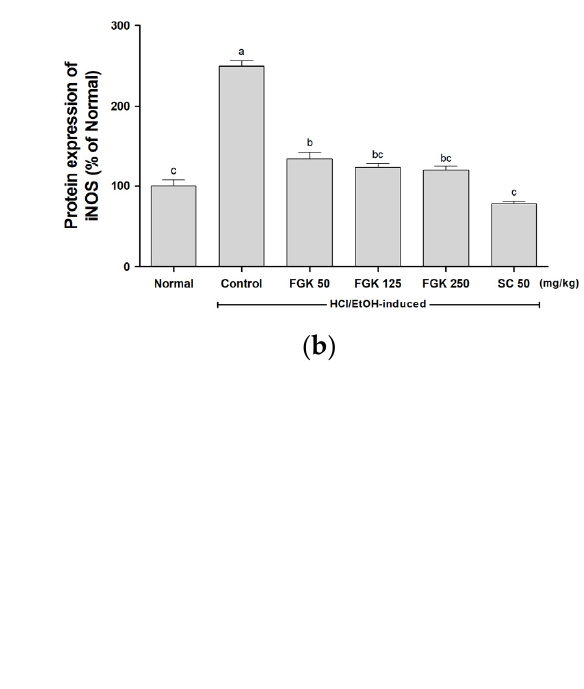
Figure 6. Effect of fermented gold kiwi (FGK) on protein expression in stomach tissues of HCl/EtOH-induced rats. ( a ) Protein expression; ( b ) iNOS/ β -actin percentage of normal; ( c ) COX- 2/ β -actin percentage of normal. Normal, rats treated with only DW; Control, rats treated with HCl/EtOH; SC 50, rats treated with HCl/EtOH and sucralfate; FGK, rats treated with HCl/EtOH and FGK (50, 125, and 250 mg/kg). Results are expressed as mean ± SEM (N = 8). a–d Different labels were significantly different at p < 0.05 between treatments, as determined by Tukey’s analysis.